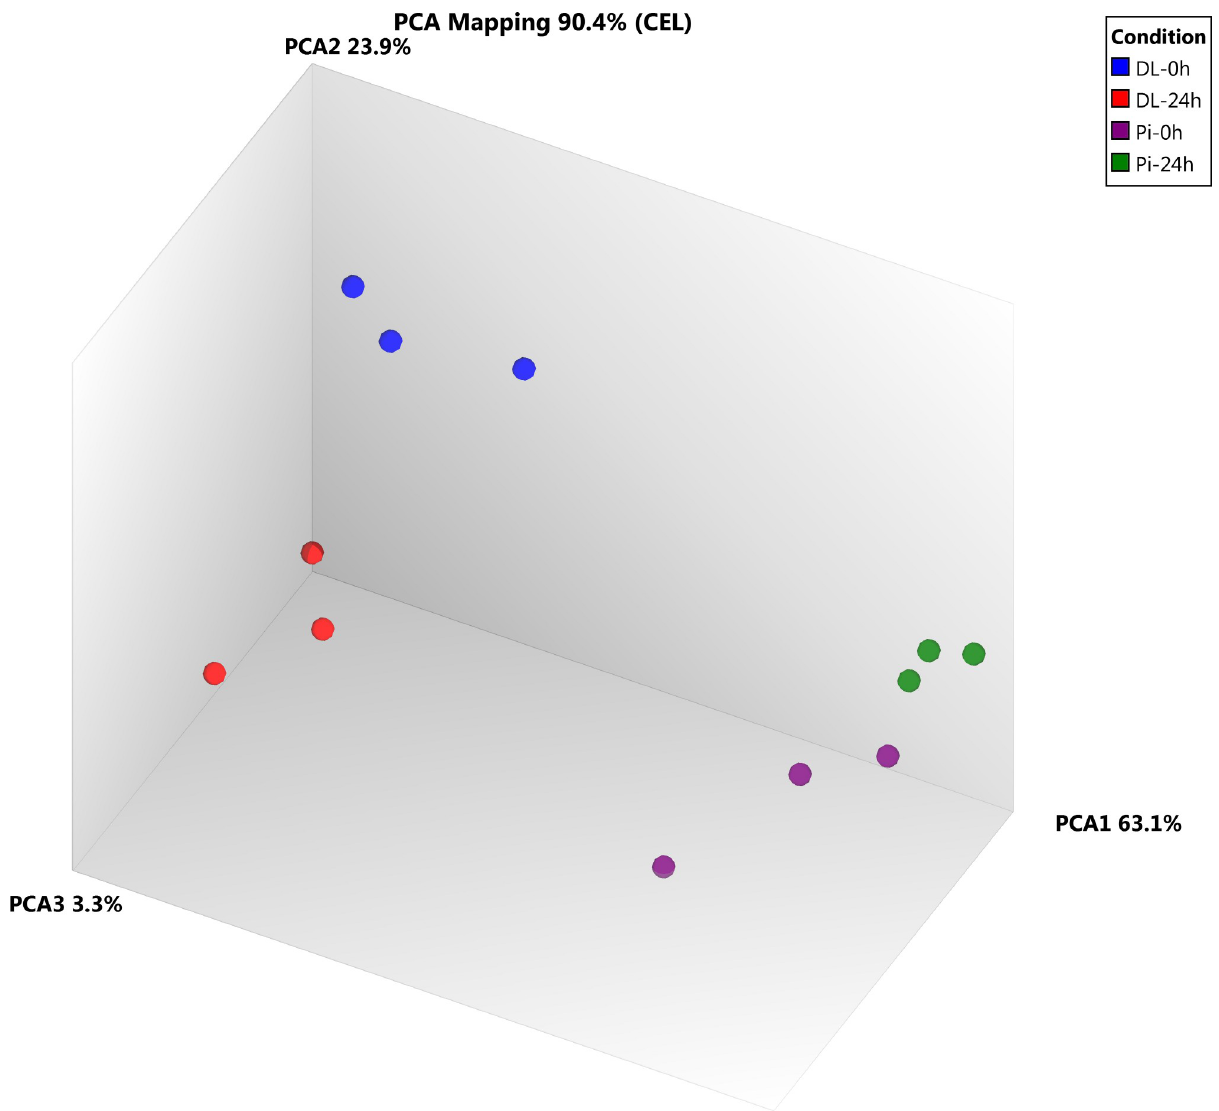
Fig 1. Principal component analysis (PCA) plot showing the sample characteristics based on microarray expression data. Each solid circle indicates the normalized gene expression of one microarray sample and the color of the circle indicate treatment condition.